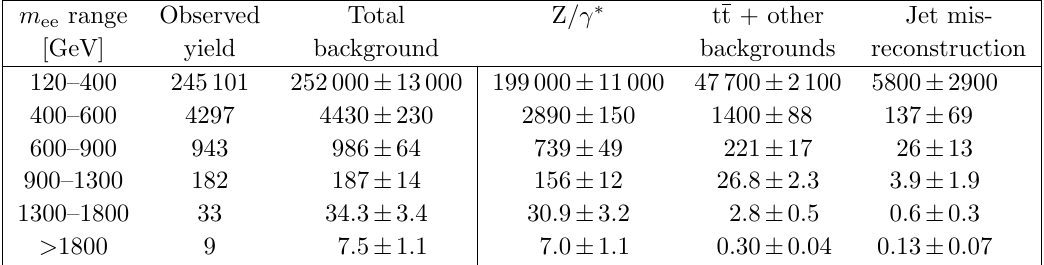
Table 2 . The number of dielectron events in various invariant mass ranges. The total background is the sum of the events for the SM processes listed. The yields from simulation are normalized relative to the expected cross sections, and overall the simulation is normalized to the observed yield using the number of events in the mass window 60{120 GeV. Uncertainties include both statistical and systematic components, summed in